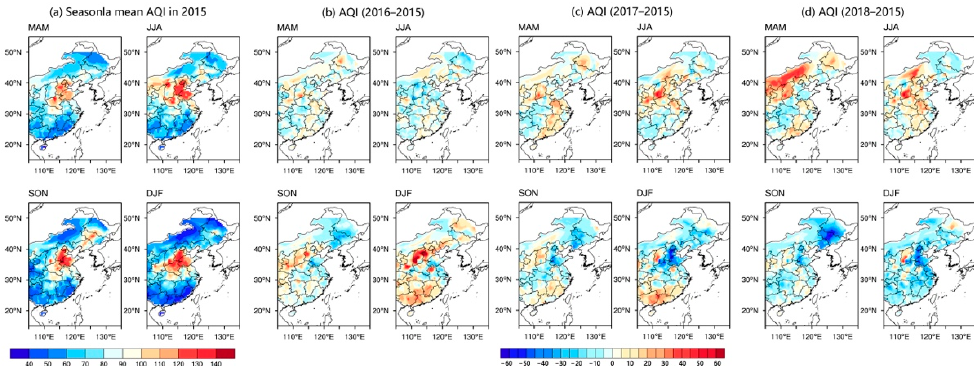
Figure 2. Spatial distributions of seasonal mean AQI in 2015 ( a ), and the differences of corresponding seasons with the years 2016 ( b ), 2017 ( c ), and 2018 ( d ), respectively. MAM indicates spring, JJA indicates summer, SON indicates autumn, DJF indicates